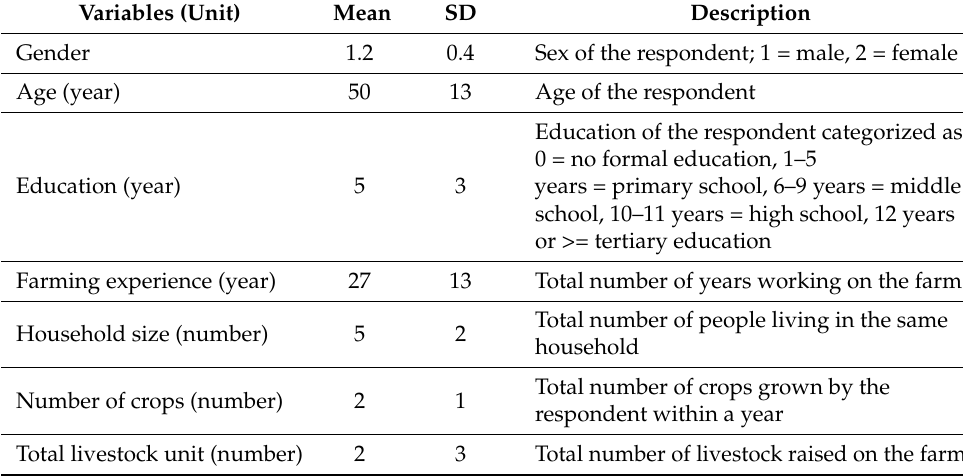
Table 3. List of variables used in